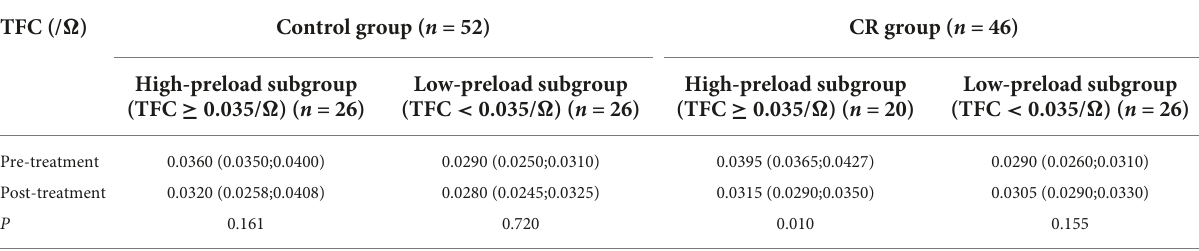
TABLE 6 Comparison of preload of patients with CHD and AHF before and after the treatment under same preload setting. TFC (/ (cid:127)